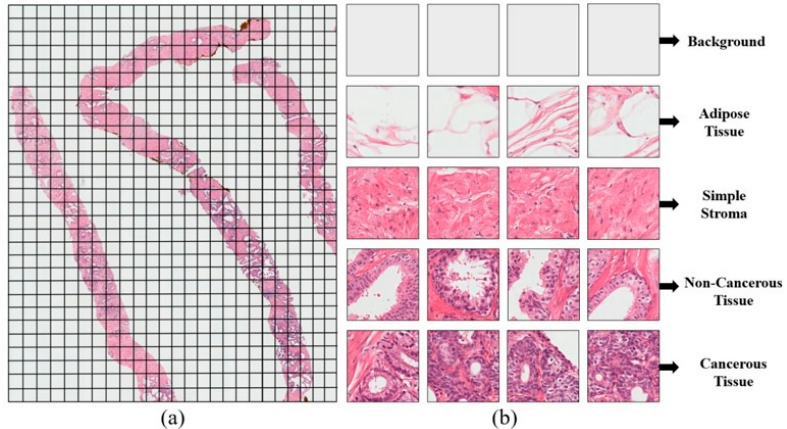
Figure 2. Data preparation of a sample histopathology slide from a prostatectomy. ( a ) An example of a whole-slide image where a sliding window method was applied to generate patch